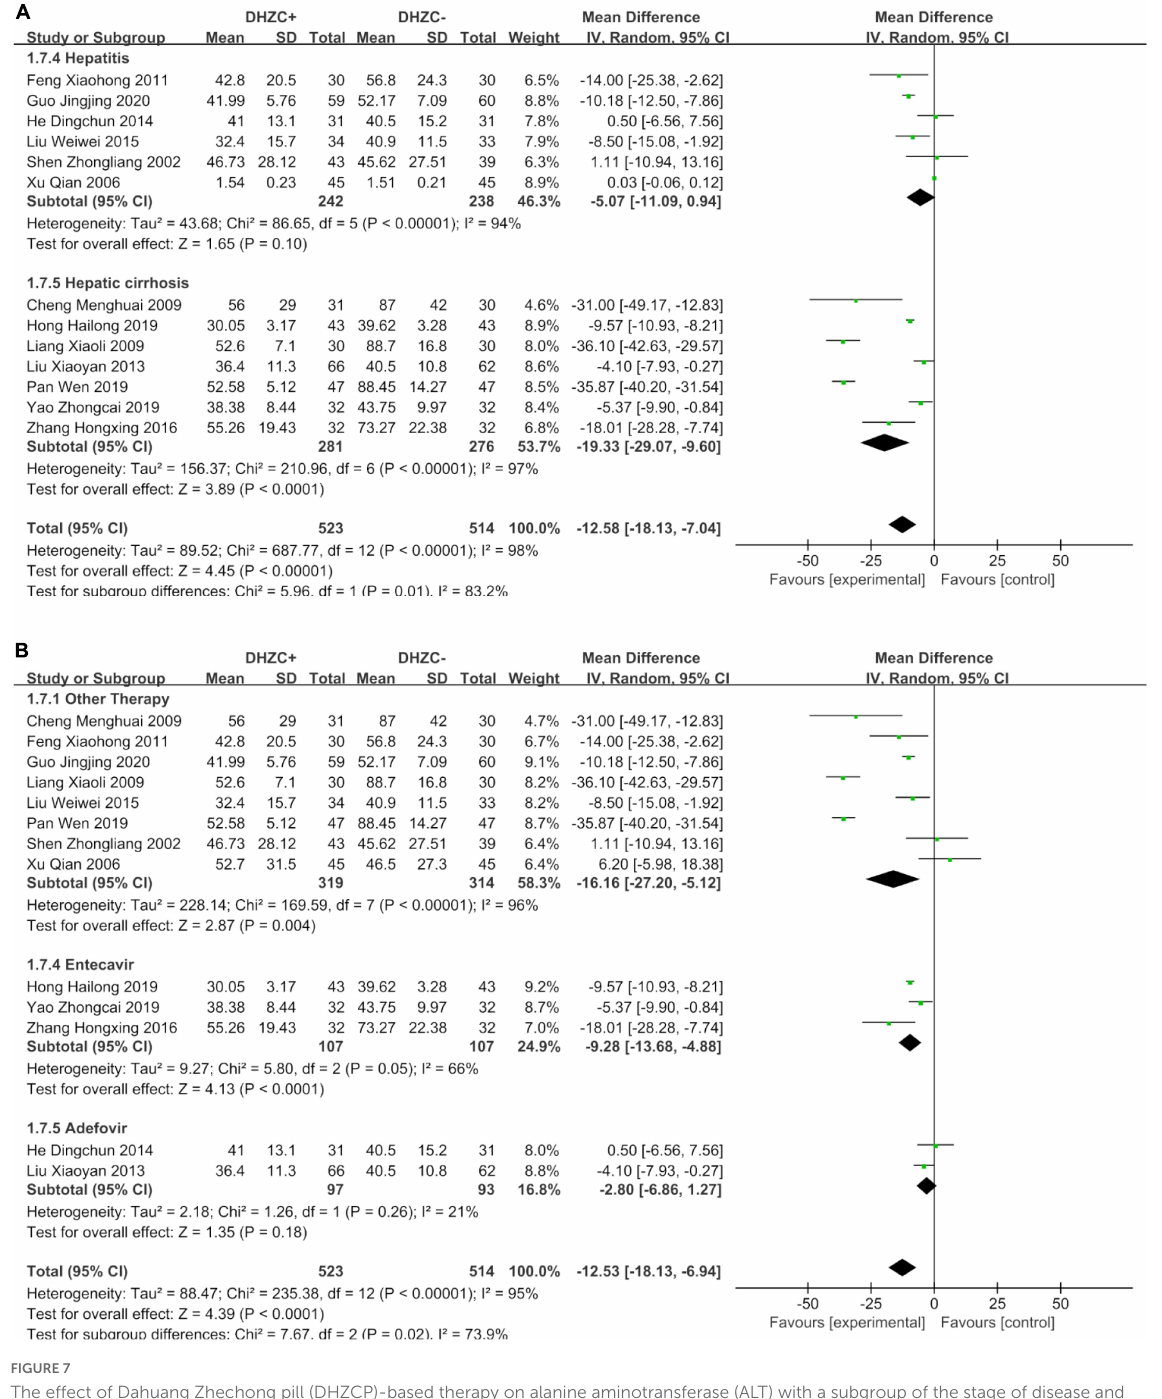
FIGURE7 The effect of Dahuang Zhechong pill (DHZCP)-based therapy on alanine aminotransferase (ALT) with a subgroup of the stage of disease and medication use. Random-effects models were applied. (A) ALT with a subgroup of the stage of disease; (B) ALT with a subgroup of medication